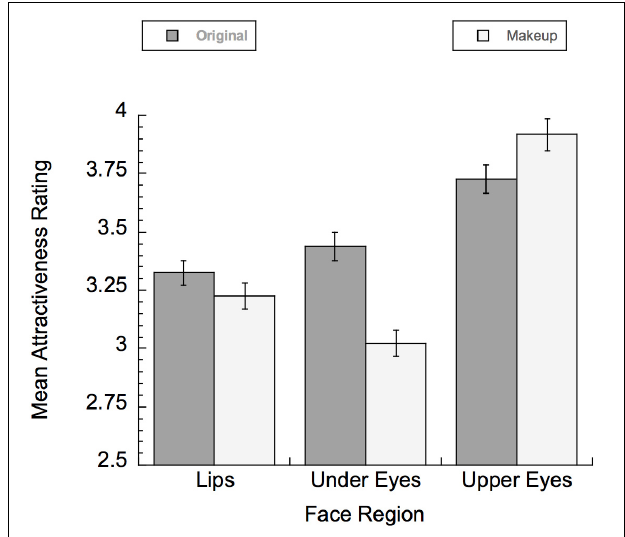
FIGURE 5 | Mean attractiveness ratings for faces with makeup applied to the lips, under eye, or upper eye